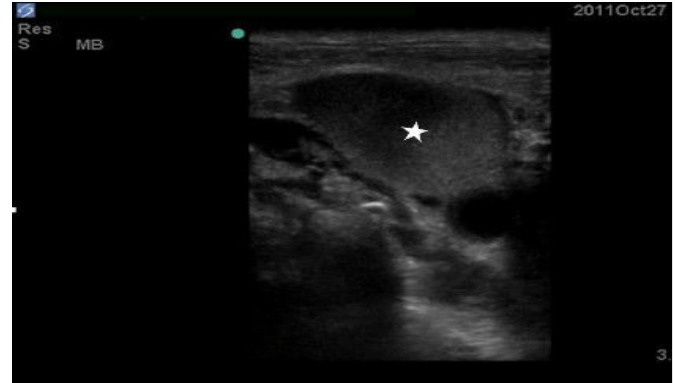
Figure 2. Ultrasound image demonstrating clot in right IJ (star).